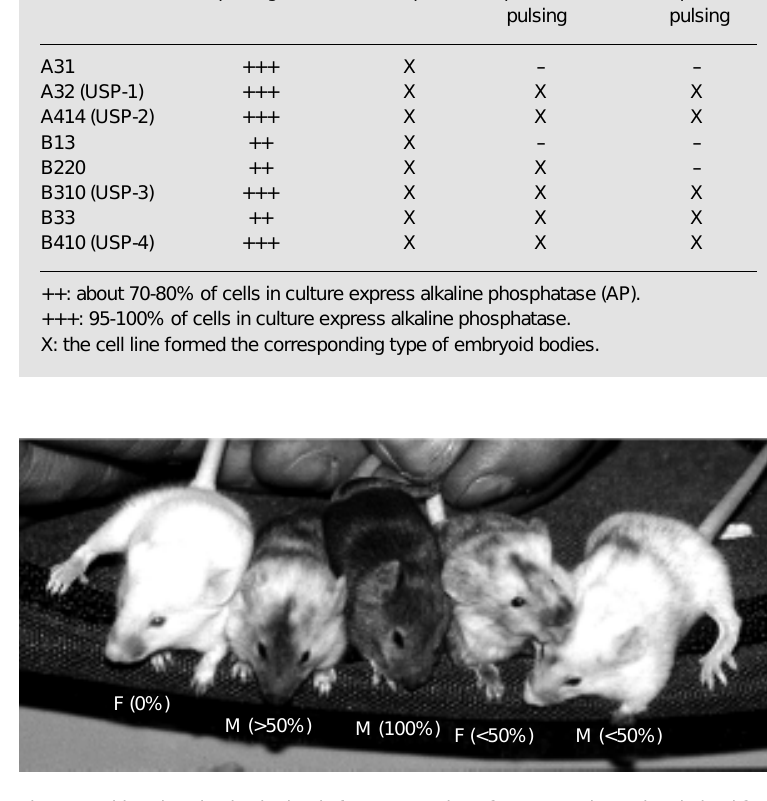
Figure 3. Chimeric animals obtained after aggregation of compacted morulae derived from CD-1 strain with USP-1 embryonic stem cell line. Percentages refer to the levels of coat color chimerism in each animal. M: male;